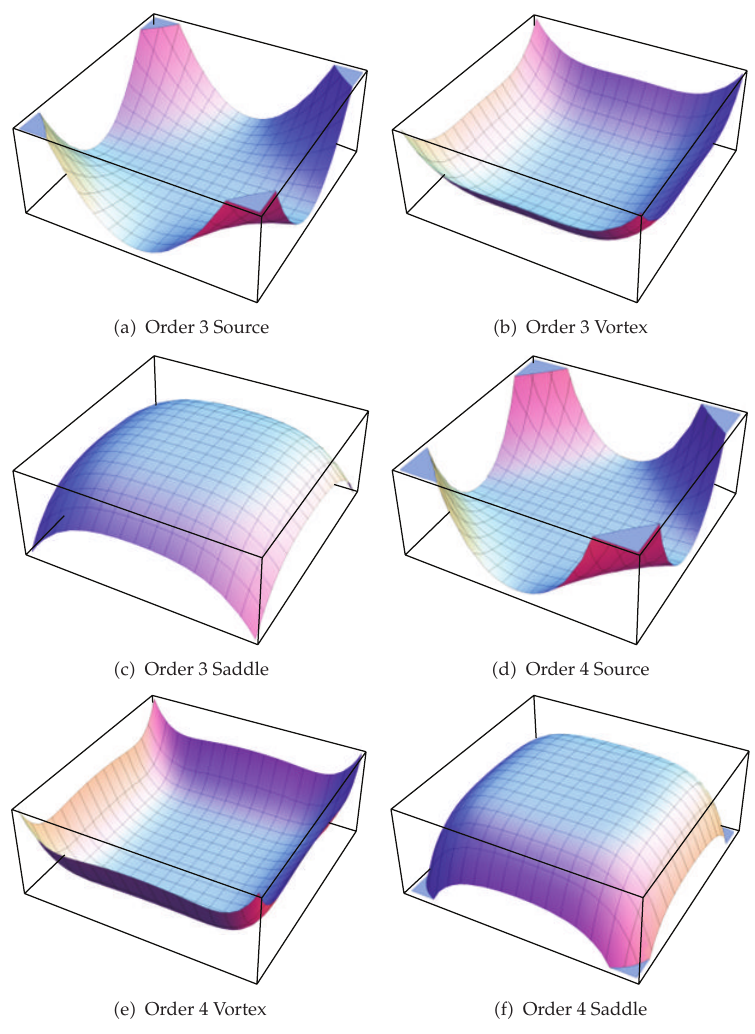
Figure 20: Saddles are indicated by concavity of the Lamb divergence.